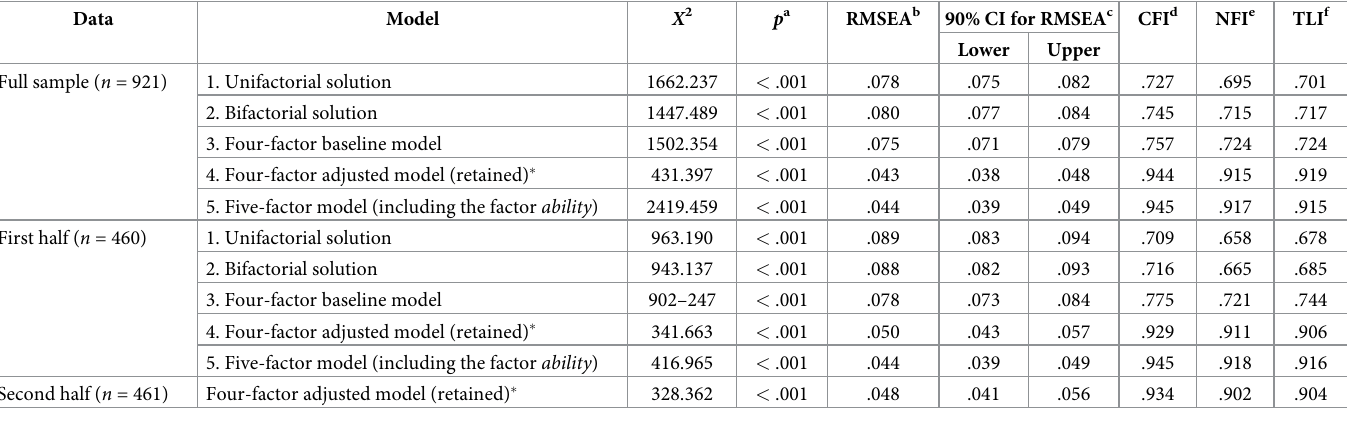
Table 3. Competitive CFA–goodness-of-fit indices obtained for the structural